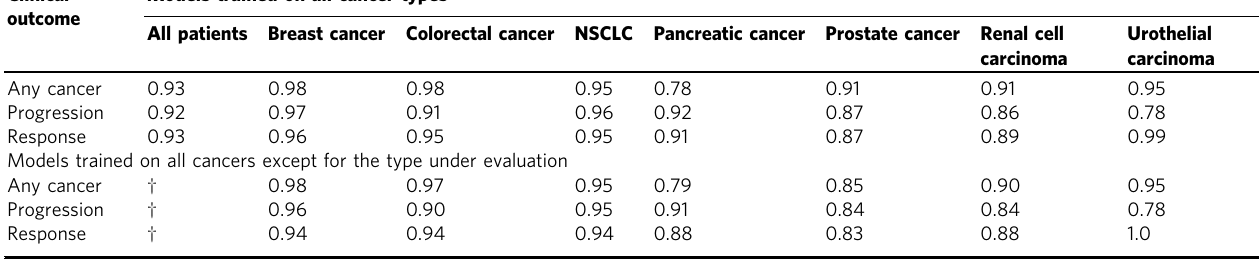
Table 5 Association between PRISSMM outcomes and overall survival among patients receiving palliative-intent systemic therapy (Hazard ratio, 95% con fi dence interval).